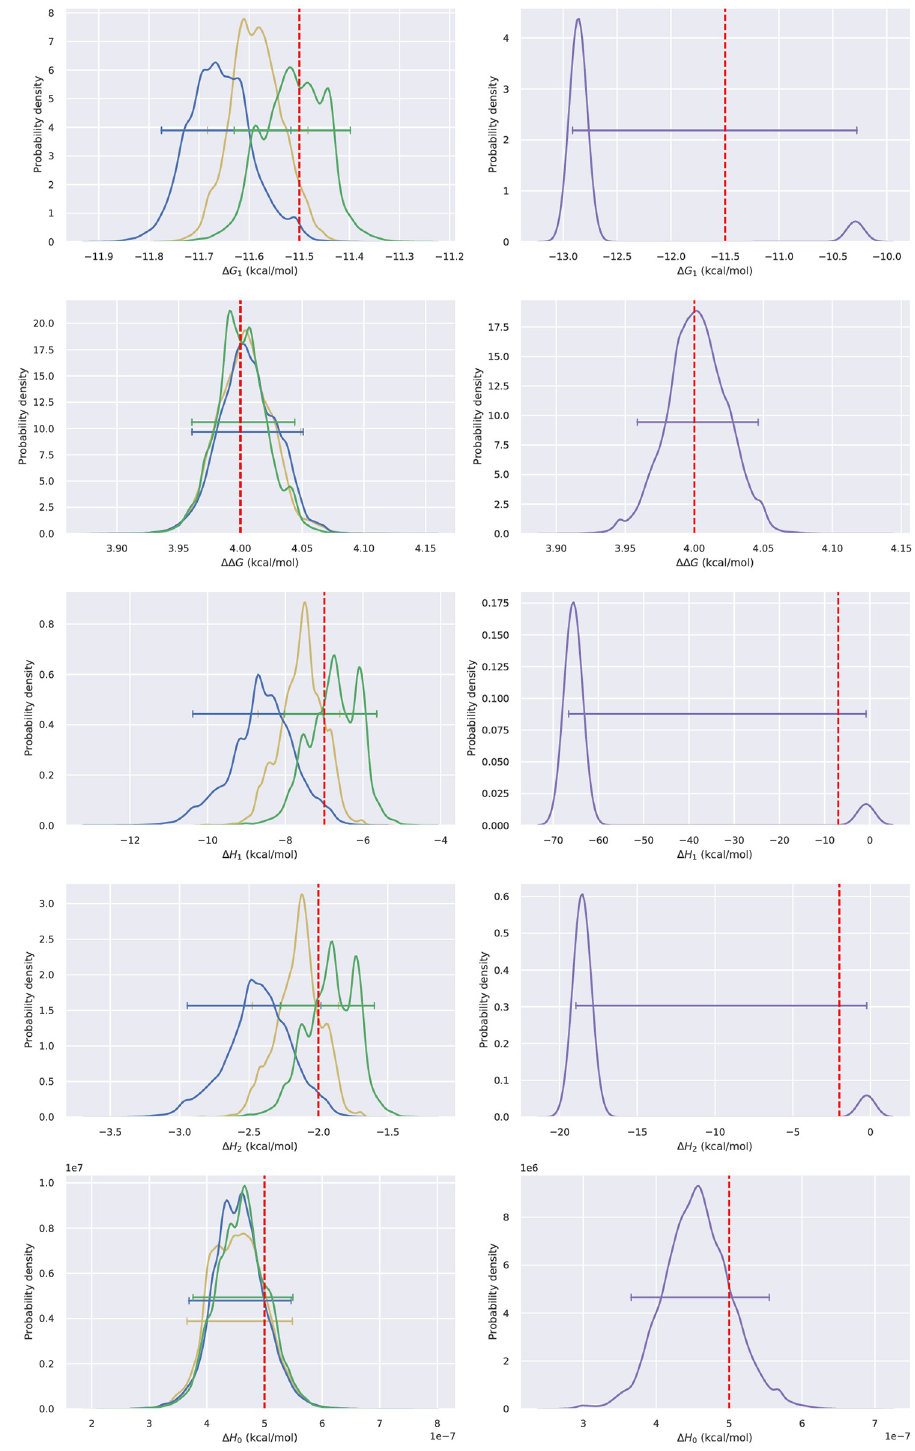
Fig 3. Representative 1D histograms of thermodynamic parameters sampled from the Bayesian posterior with four concentration priors. Priors for the concentration were lognormal for both [ L ] s and [ R ] 0 (yellow line), lognormal for [ L ] and uniform for [ R ] 0 (green line), uniform for [ L ] and lognormal for [ R ] 0 (blue line), or uniform for both [ L ] s s and uniform for [ R ] 0 (purple line). Integrated heats are from a representative simulation from the EM model. Horizontal bars show 95% Bayesian credible intervals. True values for parameters were shown as red dashed